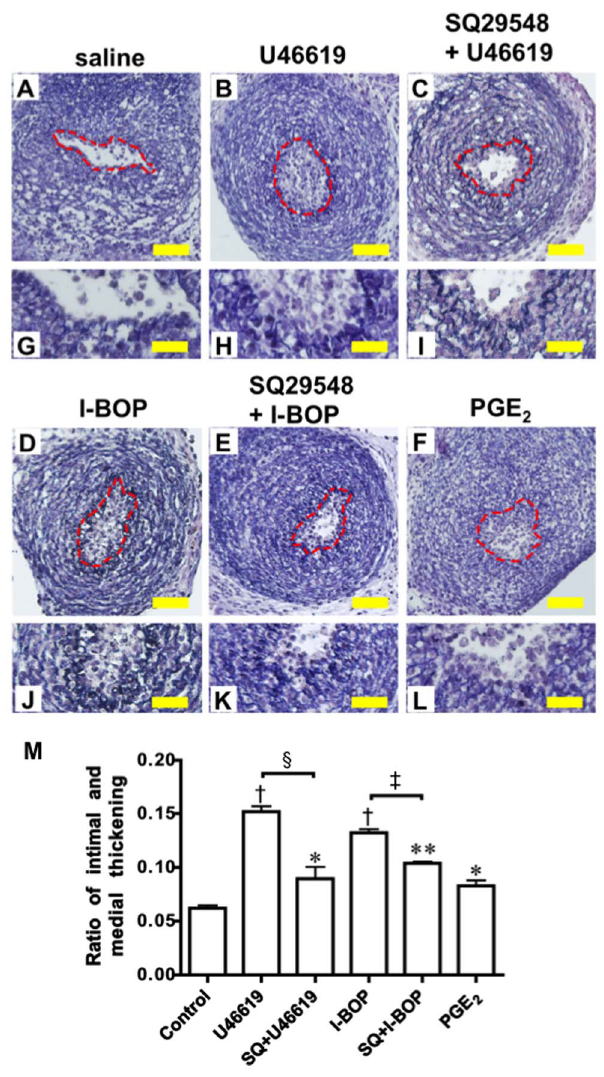
Figure 1. TP stimulation induced DA intimal thickening. (A–F) DA explants incubated with saline- (A), U46619- (B), SQ29548 + U46619- (C), I-BOP- (D), SQ29548 + I-BOP- (E), or PGE 2 - (F) containing medium for 48 hours. Broken red line indicates the elastic lamina. (G–L) Magnifica- tions of A to F. (M) Evaluation of the intimal thickening. Values are expressed as the mean 6 SEM. n=3 to 7. *, **, and { indicate p , 0.05, p , 0.01, and p , 0.001 versus control, respectively; 1 indicates p , 0.001 versus U46619; ` indicates p , 0.001 versus I-BOP. Scale bar: 40 m m (A–F) and 20 m m (G–L).